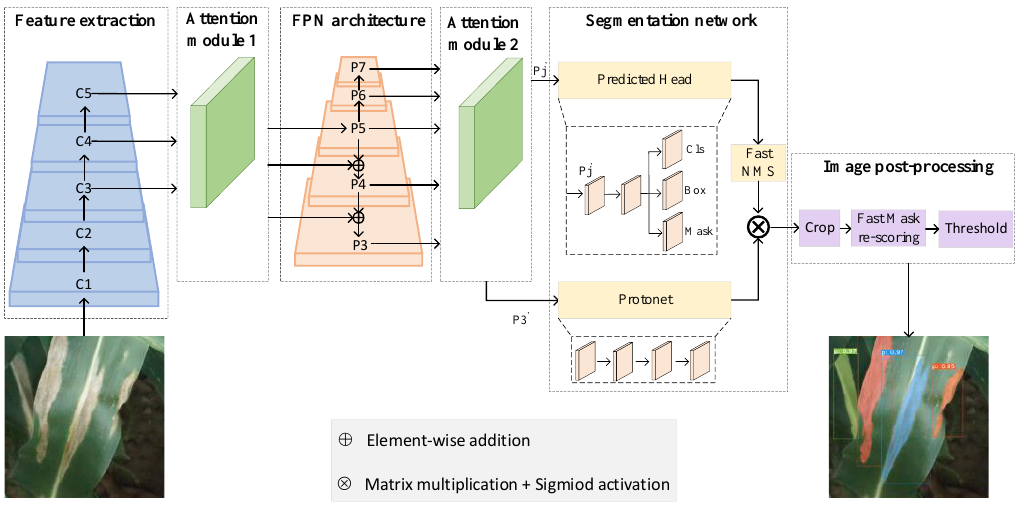
Figure 3. The proposed attention-based YOLACT++ architecture.